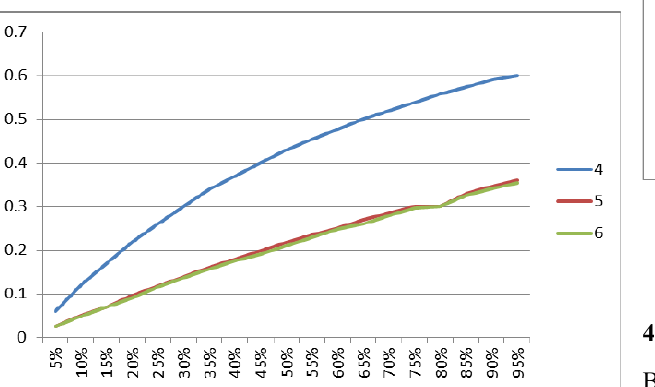
Fig. 12. Collision ratio per string length, Murmur, linked, size=25165843